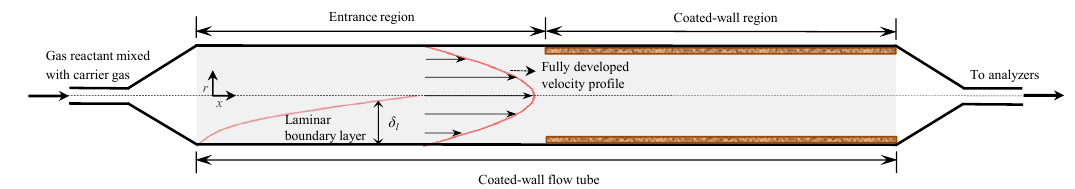
Figure 2. Development of laminar boundary layer and flow velocity profile within the coated-wall flow tube used for soil uptake experiments ( d = 7mm, L = 250mm; Li et al.,